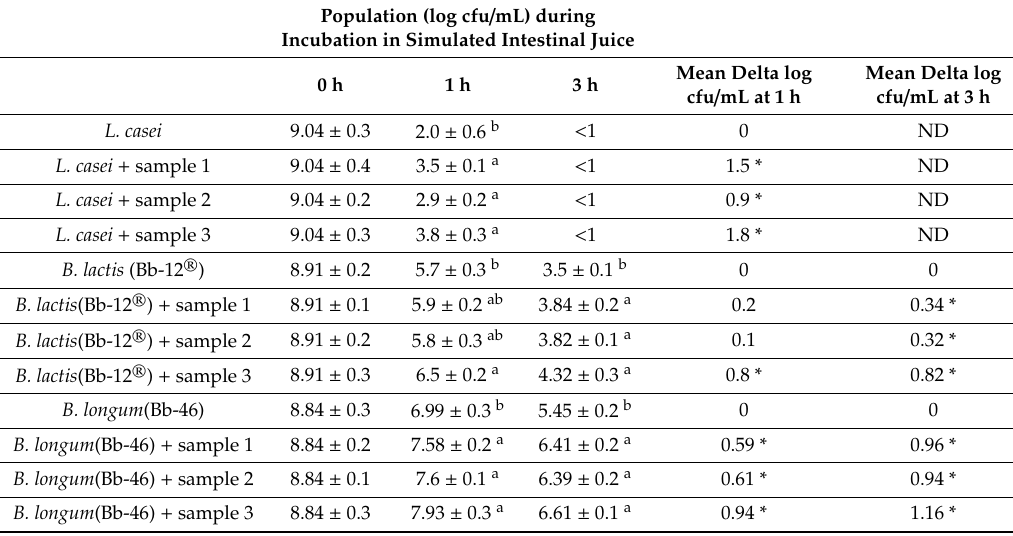
Table 5. Population (log cfu / mL) of probiotic bacteria in simulated intestinal juice medium without (control) or with the addition of encapsulated Goji berry extracts (samples